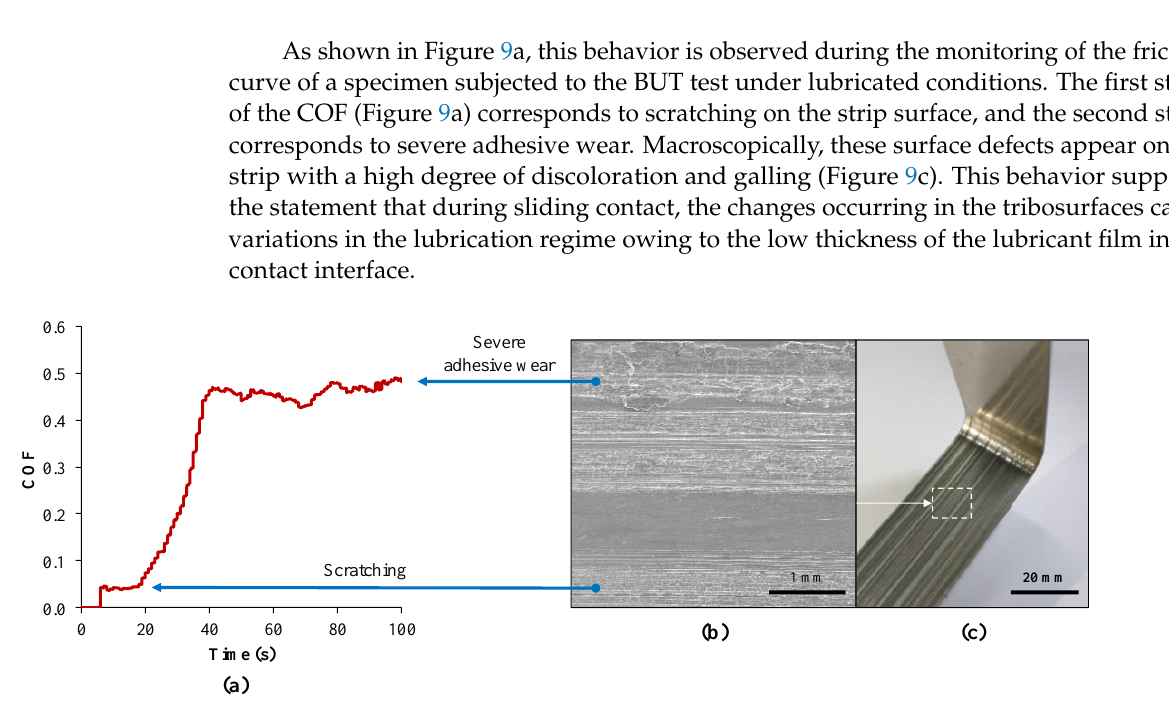
Figure 10. COF values obtained in the BUT test: ( a ) dry contact and ( b ) lubricated contact.